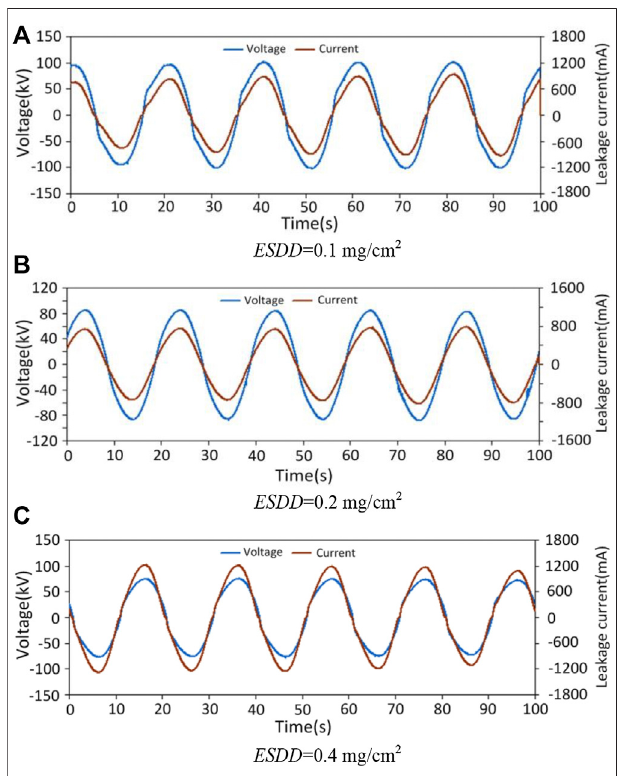
FIGURE 9 | The voltage and current waveform of pre- fl